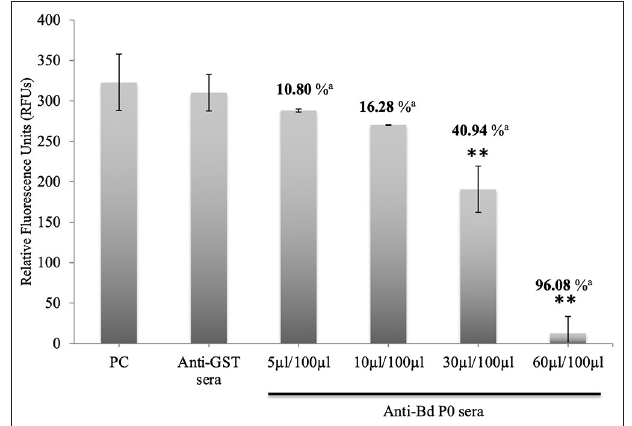
FIGURE 4 | Growth inhibitory assay of B. divergens with different concentrations of IgGs. Fluorescence values were determined on the fourth day of culture. Statistically significant differences are indicated by asterisks (** p < 0.05) between the control group that received no antibody and groups that